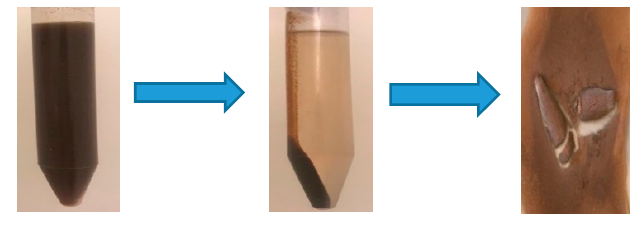
Figure 2. The synthesis of AgNPs.